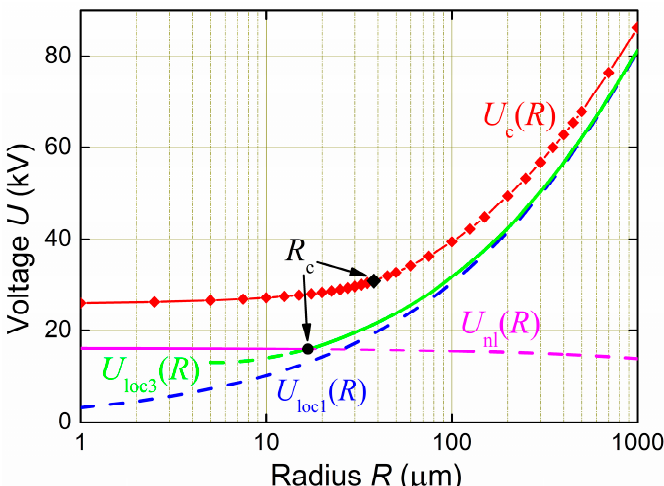
Figure 9. The dependences of the runaway threshold voltages U loc3 (green line) and U nl (magenta line) corresponding to the local and nonlocal criteria (11) and (12) on the cathode curvature radius R are shown on a logarithmic scale along the abscissa. Red diamonds correspond to the results of numerical calculations of Section 4. Black dots indicate the boundary values of the radius calculated numerically (diamond) and analytically (circle), separating the regions of applicability of the nonlocal and local runaway criteria. Moreover, the dependence U loc1 ( R ) corresponding to the classical local runaway criterion E 0 > E c (dashed blue line, expression (8)) is shown for